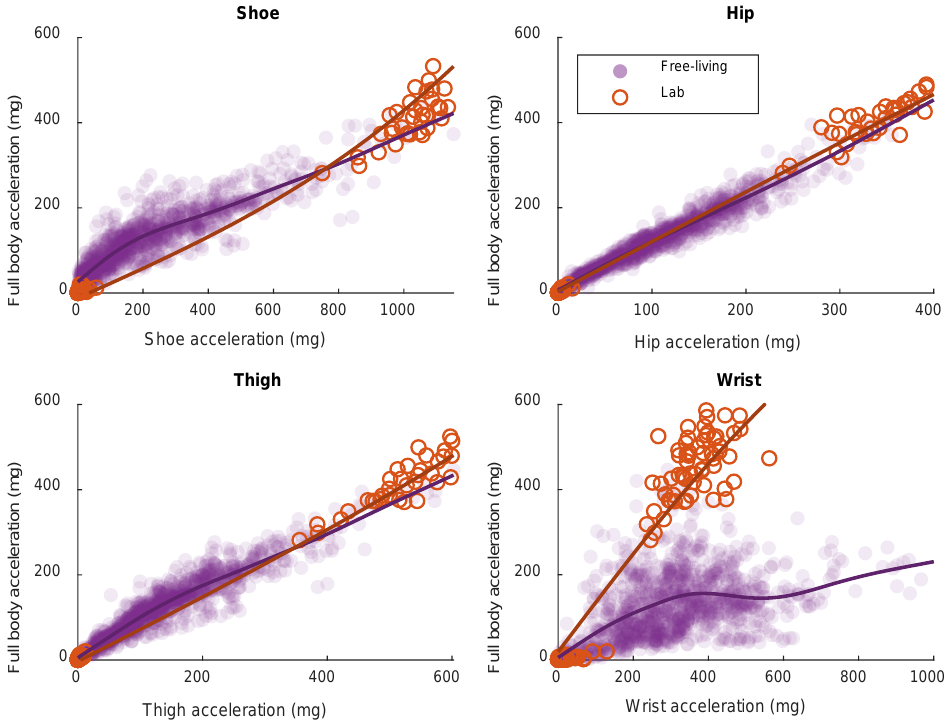
Figure 4. Association between single-accelerometer output and full-body acceleration in laboratory and free-living, based on smoothing splines.